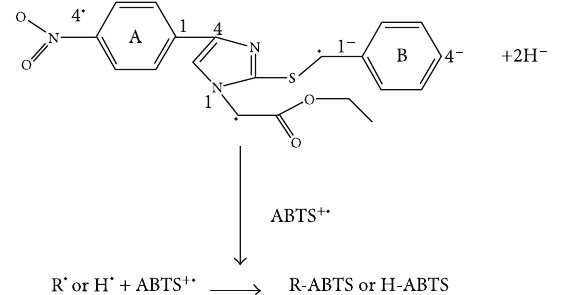
Figure 5: Second suggested mechanism for the antioxidant activity of active ingredient separated from E. compressa against ABTS